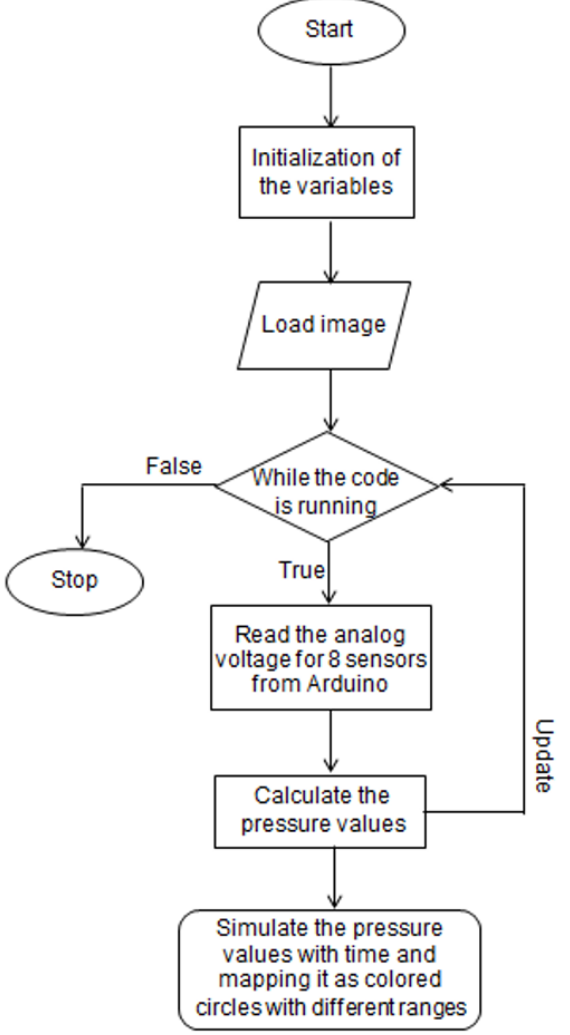
Figure 6. The flowchart of the MATLAB code that was used for data processing.